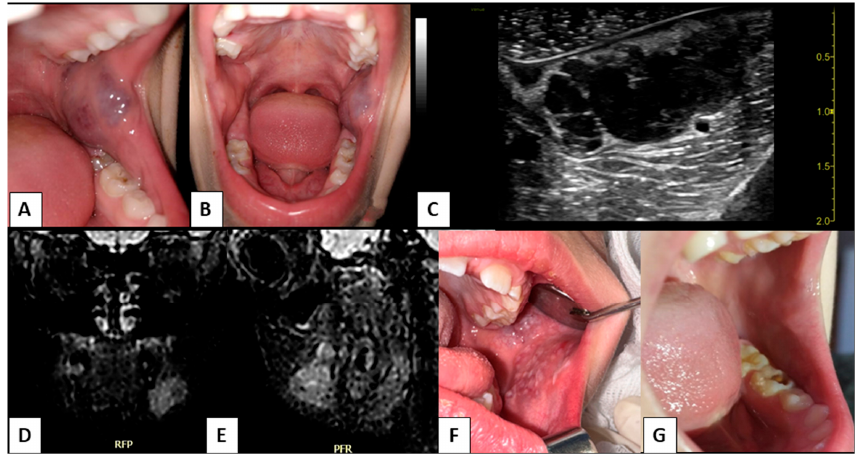
Figure 1. (A , B ): capillary-venous malformation of left cheek in a six-year-old patient; ( C ): preoperative intraoral high-definition ultrasonography; ( D , E ): preoperative magnetic resonance imaging; ( F ): the lesion after transmucosal and intralesional thermo-photocoagulation; ( G ): follow-up after second session of laser photocoagulation. Children 2023 , 10 , x FOR PEER REVIEW